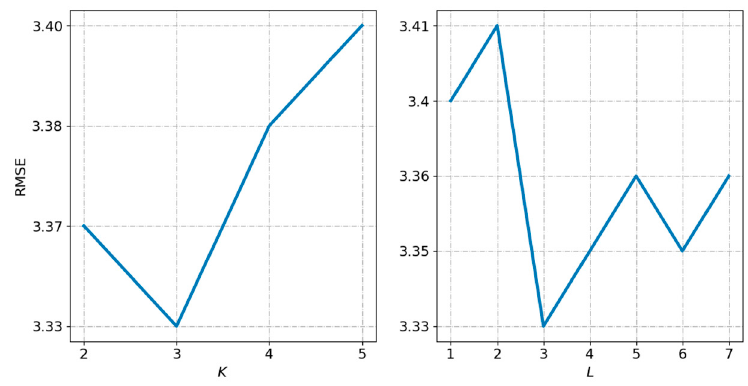
Figure 6. Tuning the number of layers. Figure 6 . Tuning the number of layers.